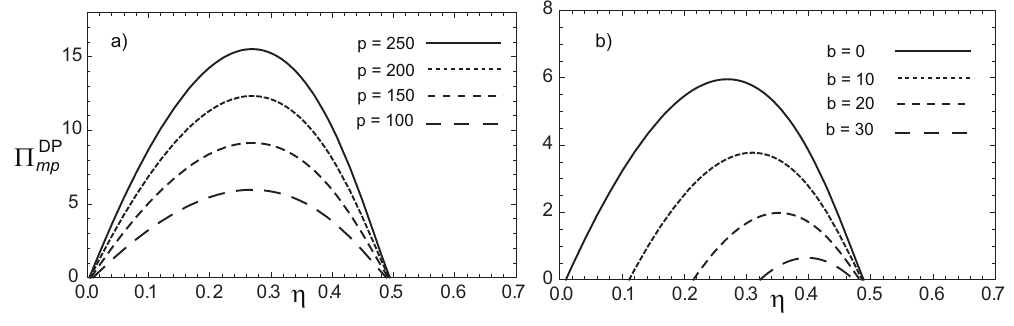
Figure 6. Profit function (cid:5) DP in terms of the engine’s efficiency η under a DP heat transfer mp law for a) b = 0 and taking several values of p and b) p = 100 and taking several values of b